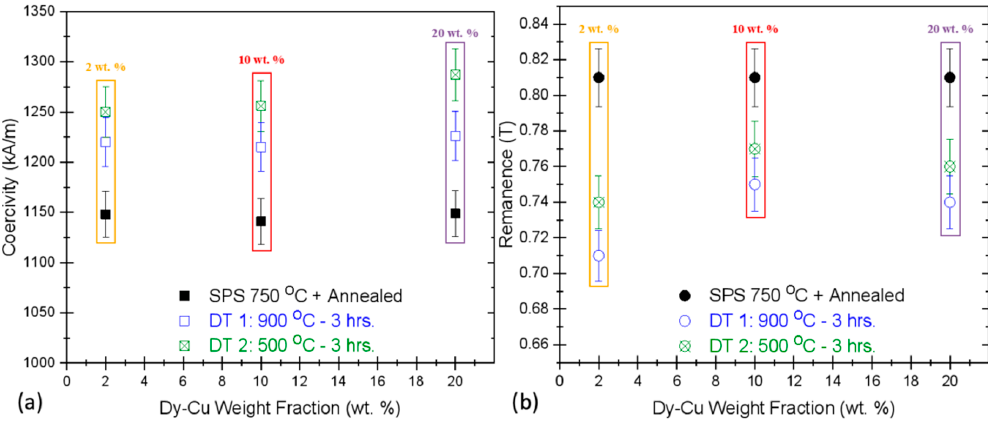
Figure 1. ( a ) Dependence of coercivity ( H Ci ) and ( b ) remanence ( B r ) with different weight fractions of eutectic Dy 70 Cu 30 alloys during the two stages of GBD treatment. Plots legend: yellow 2 wt. %, red 10 wt. % and purple 20 wt. % Dy-Cu as the diffusion source on bulk SPS reprocessed magnets (RMs).